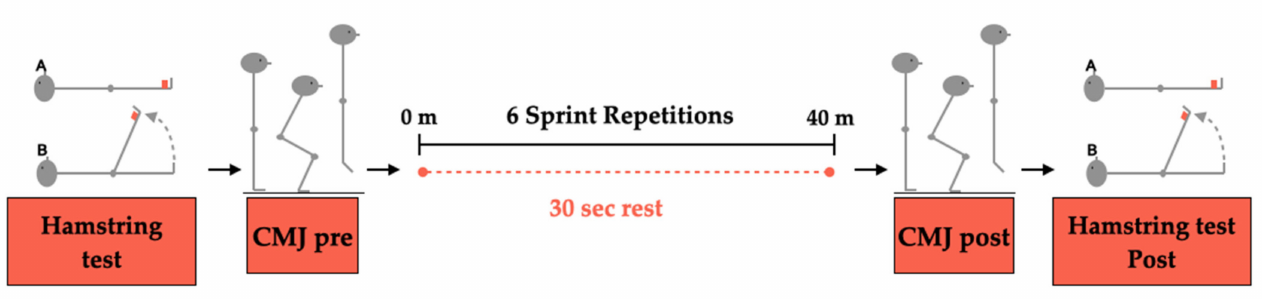
Figure 1. Outline of the protocol